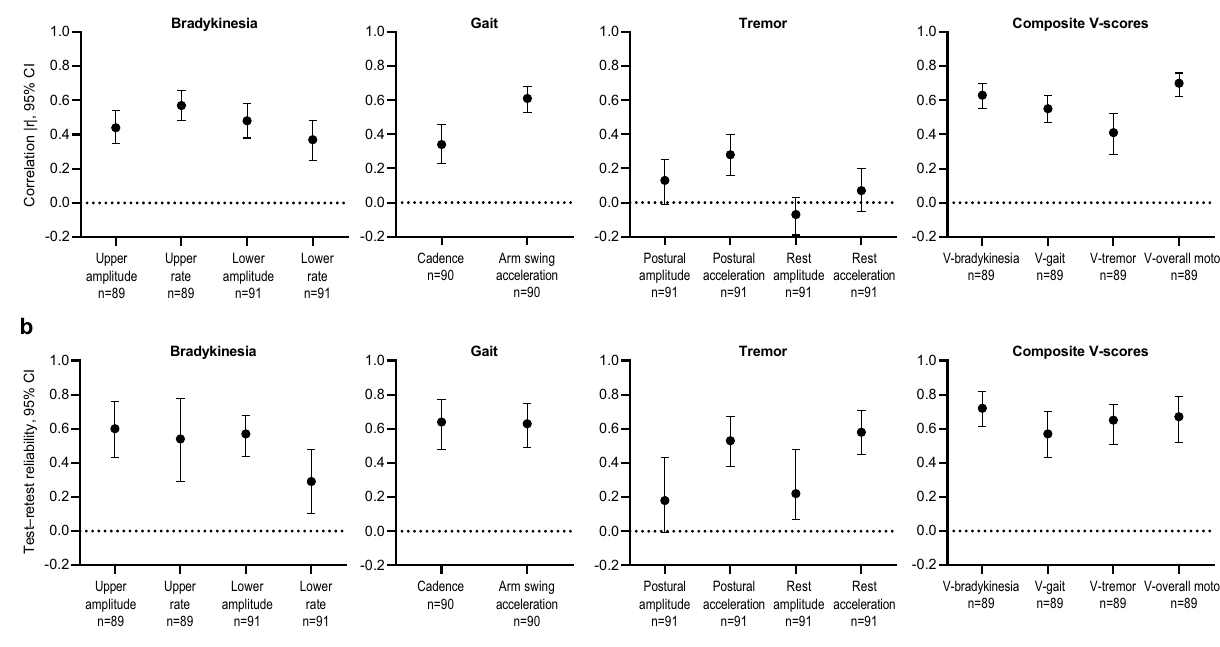
Figure 4. Analytical validity of digital measurements from single-sensor–derived features and composite V-scores. ( a ) Spearman rank correlation between MDS-UPDRS Part III sensor scores and neurologist-rated consensus scores on Day 3 and ( b ) test–retest reliability on Day 2 of the inpatient assessment. a,b Consensus scores for the MDS-UPDRS Part III examination on Day 3 of the inpatient assessment were calculated using an in-person rating from videotaped ratings from three neurologists. The averages of all scores for the OFF and ON states on Day 3 were combined for each measure. a Spearman rank correlation coefficients are plotted as absolute values; original values are plotted for coefficients where the 95% CI crosses the 0 line. Correlation was considered weak for coefficients < 0.3, moderate for coefficients 0.3–0.6, and strong for coefficients > 0.6. b Test–retest reliability was computed from MDS-UPDRS Part III sensor scores on Day 2, in which the MDS-UPDRS examination was administered twice within a short period of time; test–retest reliability was considered poor for ICCs < 0.5, average for ICCs 0.5–0.75, good for ICCs > 0.75–0.9, and excellent for ICCs > 0.9. CI confidence interval, ICC intraclass correlation coefficient, MDS-UPDRS Movement Disorder Society-sponsored revision of the Unified Parkinson’s Disease Rating Scale, V-score machine-learned composite sensor scores for each motor